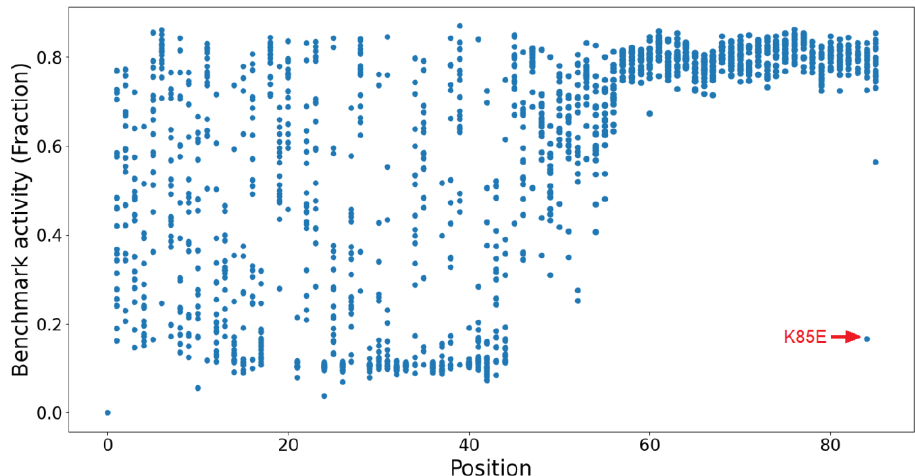
Figure 3. Tat variant activity is partially dependent upon the amino acid position. Each dot represents a Tat variant. The outlier K85E is highlighted in the figure.